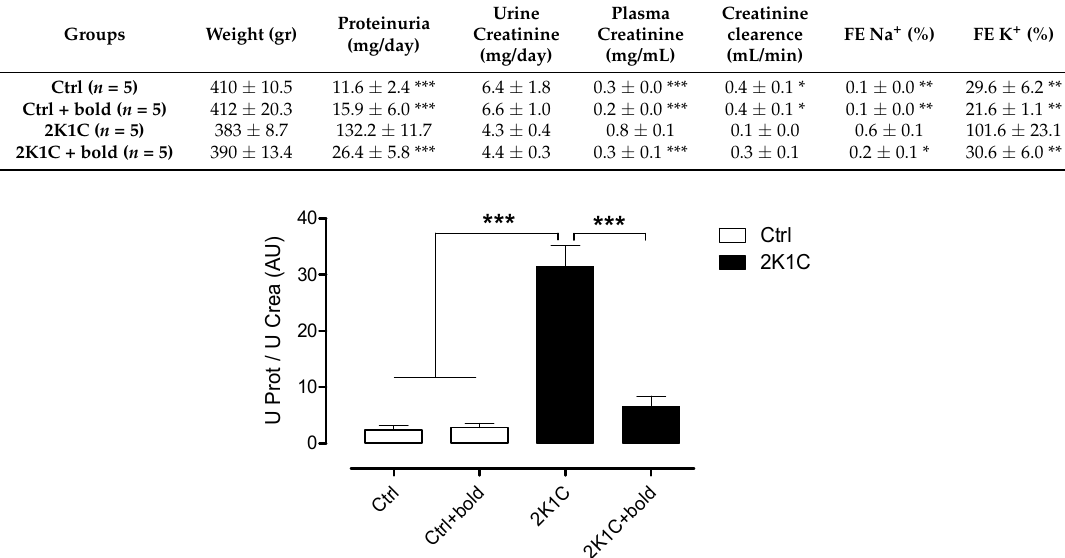
Figure 1. The renal function is improved in 2K1C hypertensive rats treated with boldine. Protein and creatinine were measured in urine samples to assess renal function. Bars represent the mean ± SE. The differences were evaluated by analysis of variance followed by the Tukey post-hoc test. *** p < 0.001 vs. 2K1C ( n = 5 per group).